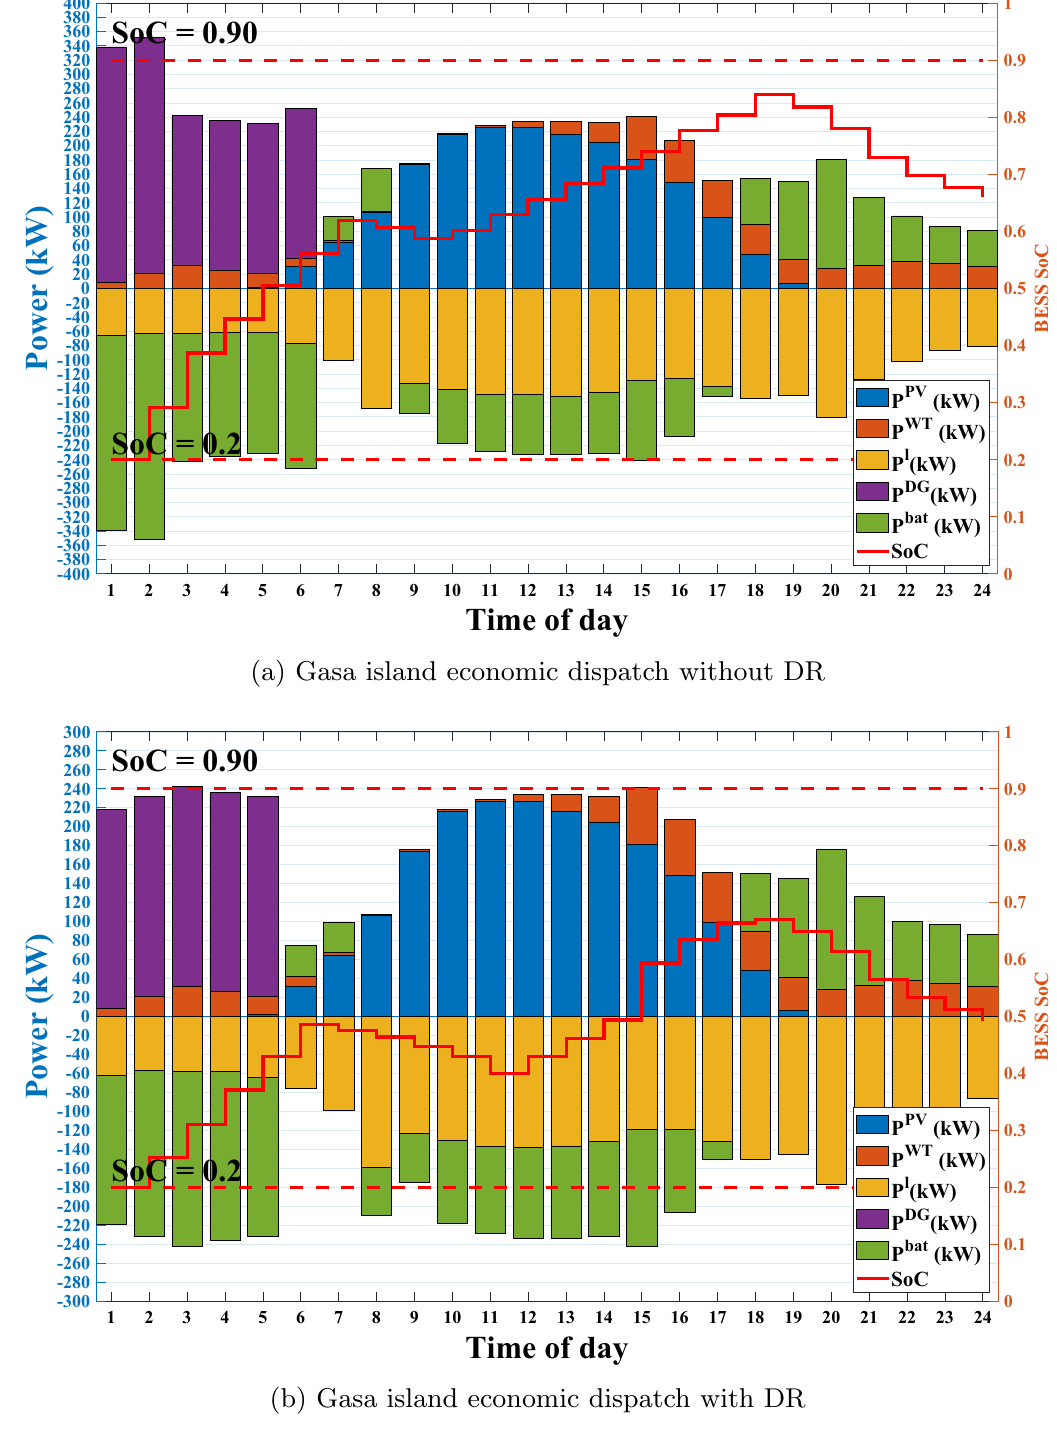
Figure 7. Economic dispatch in Gasa island microgrid with and without